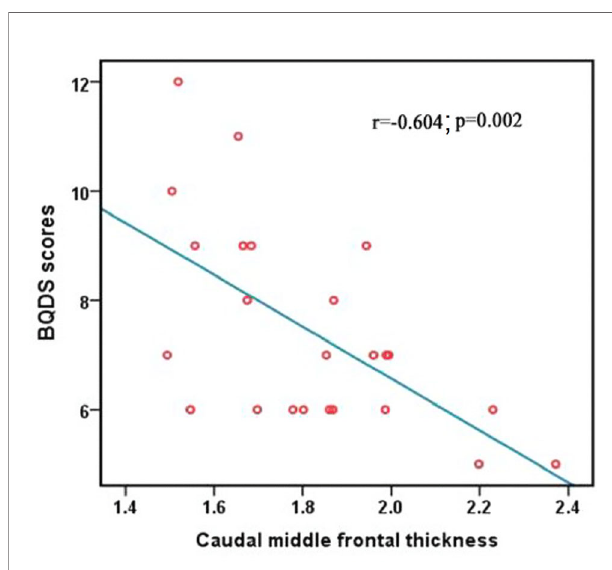
FIGURE 1 | Differences in CT between individuals with BQD and HC. Regions with decreased CT in BQ dependent individuals include the left precuneus, entorhinal, right paracentral, middle temporal gyrus, and caudal middle frontal. The color bars represent the range of t value. L, left; R, right; CT, cortical thickness; BQD, betel quid dependence; HC, healthy